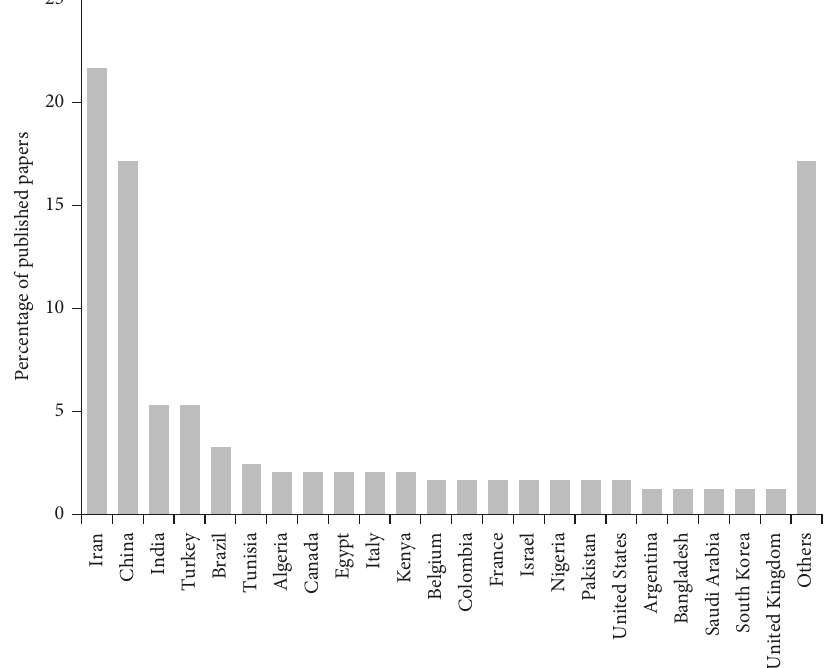
Figure 2: Distribution by country of papers published in the last